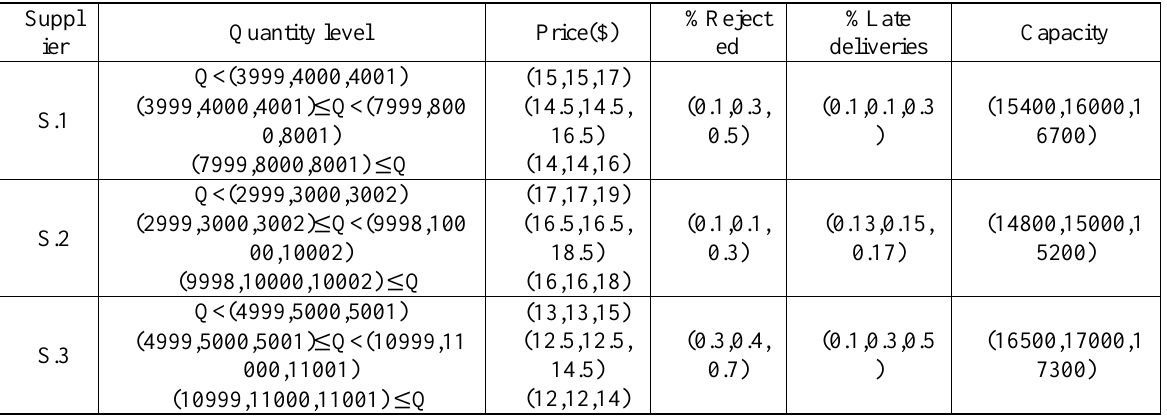
Table 1. The data set for supplier selection parameters.